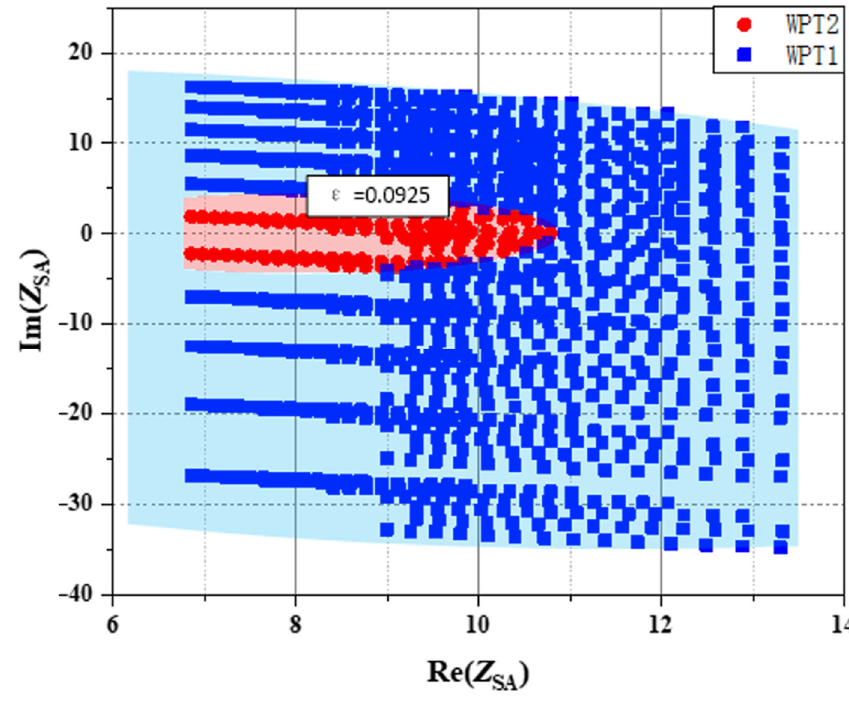
Figure 10. System output power interoperability